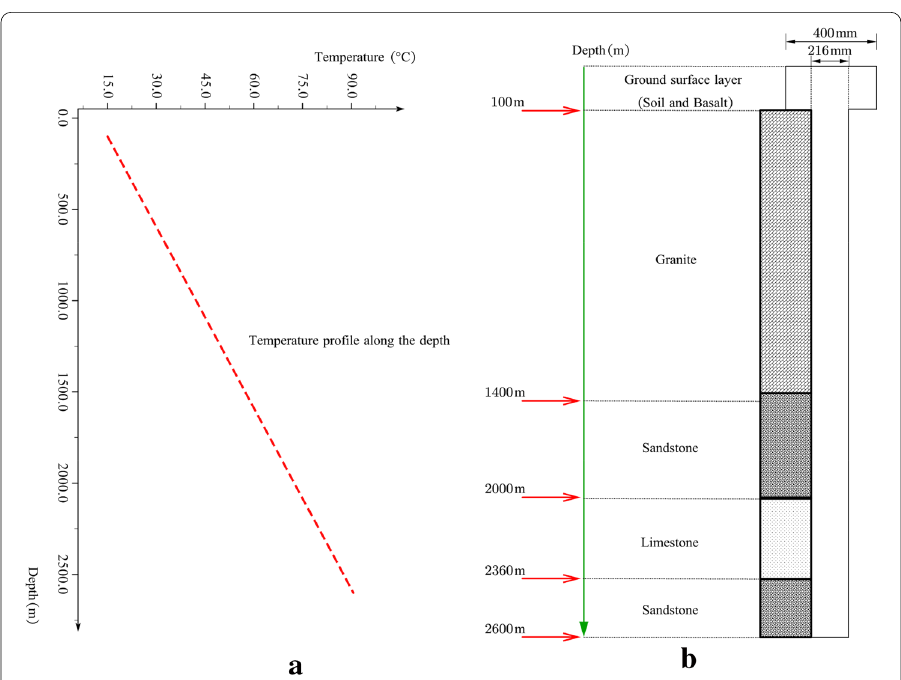
Fig. 8 Geological settings for the model in study: a Initial geothermal temperature profile underground. b Rock layers distribution